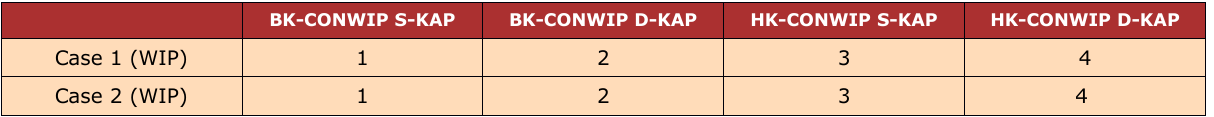
Table 20. Summary of robustness analysis ranking for